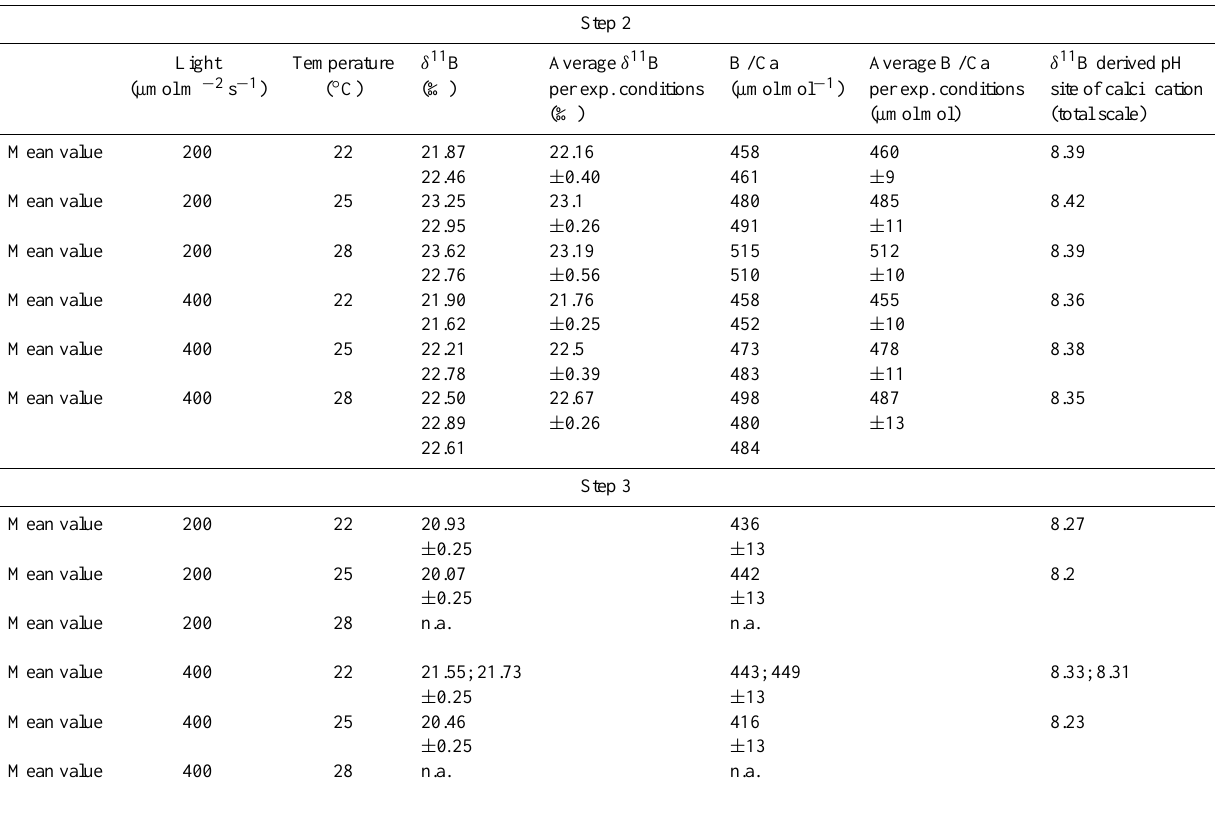
Table 4. δ 11 B (‰) and B/Ca (µmolmol − 1 ) measured at the end of steps 2 and 3. For step 2 values represent mean calculation of mea- surements performed on 2 replicates per experimental condition, with the exception of condition 400 µmolm − 2 s − 1 and 28 ◦ C where 3 replicates were considered. SD represents the combined standard deviation calculated based on the analytical uncertainty and the difference between the separate replicates. Due to sample size limitation, values presented for step 3 are based on a single sample per experimental condition; here SD represents only the analytical uncertainty. Reconstructed pH at the site of calcification using the boron isotope values and the fractionation factor determined by Klochko et al. (2006): α =1 . 0272 ± 0 . 0006 ( δ 11 B seawater =39.61‰, B T =416.0µM and T = 22 ◦ C, 25 ◦ C and 28 ◦